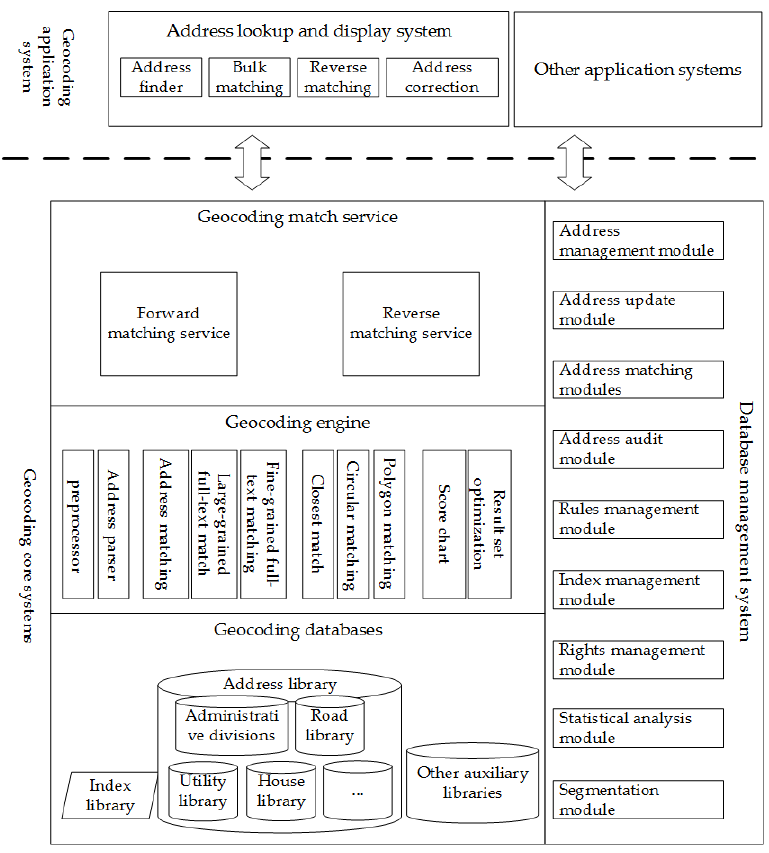
Figure 8. Architecture of the geocoding service system.